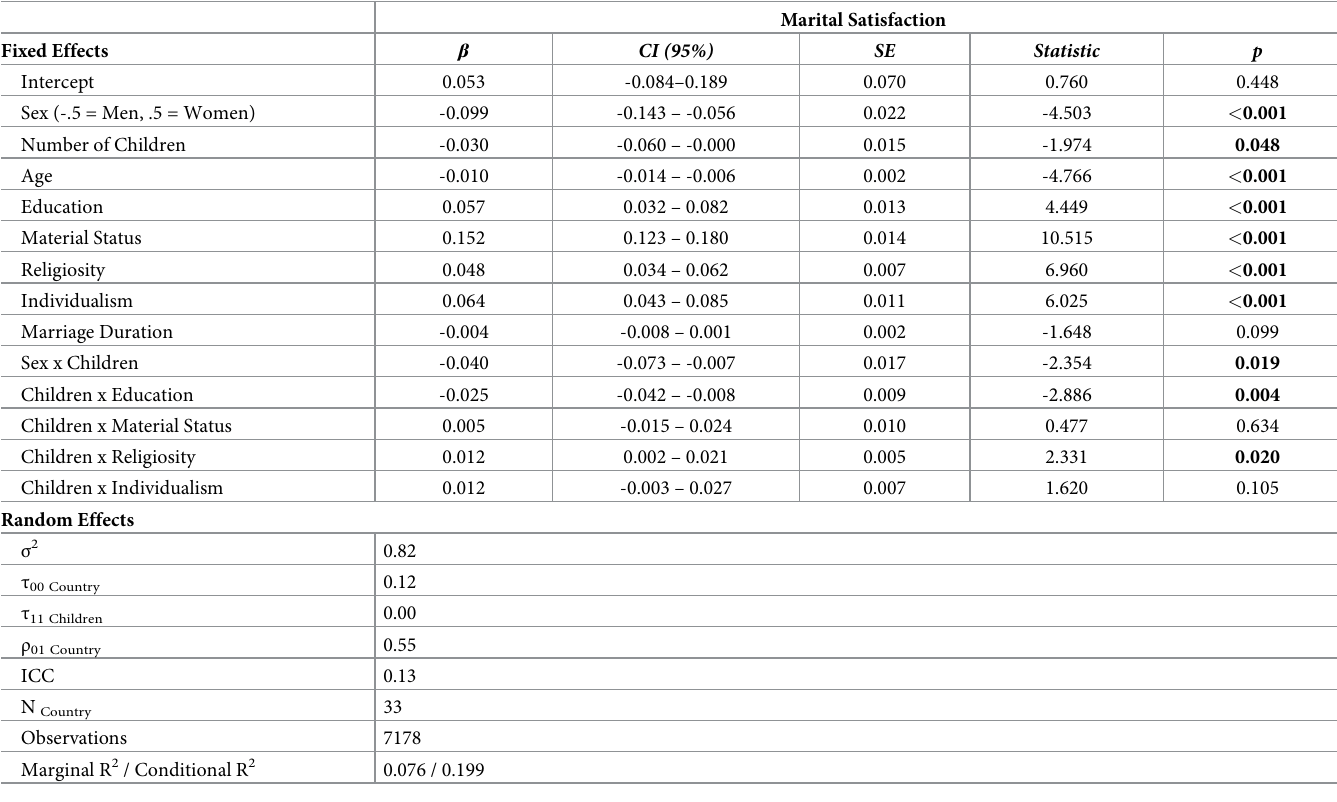
Table 2. Results of the multilevel linear model regressing marital satisfaction on number of children, sex, age, marriage duration, religiosity, education, material situation, individualism, and number of children x religiosity/education/sex/material situation/individualism.